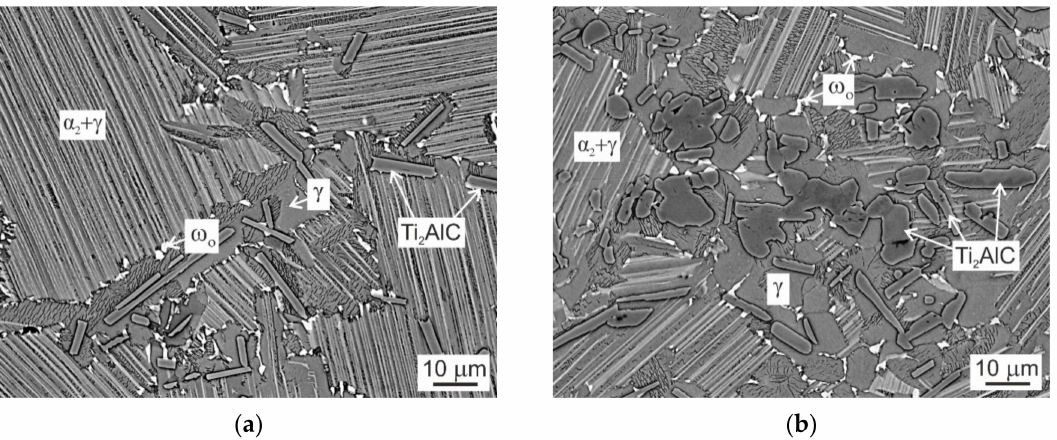
Figure 6. BSE micrographs showing the microstructure of C20 and C36 alloys after heat treatment combined with ageing: ( a ) HTA C20 alloy; ( b ) HTA C36 alloy. The coexisting phases and regions are marked in the figures. Table 4. Chemical composition of coexisting phases in HTA C20 and HTA C36 alloys (at.%).